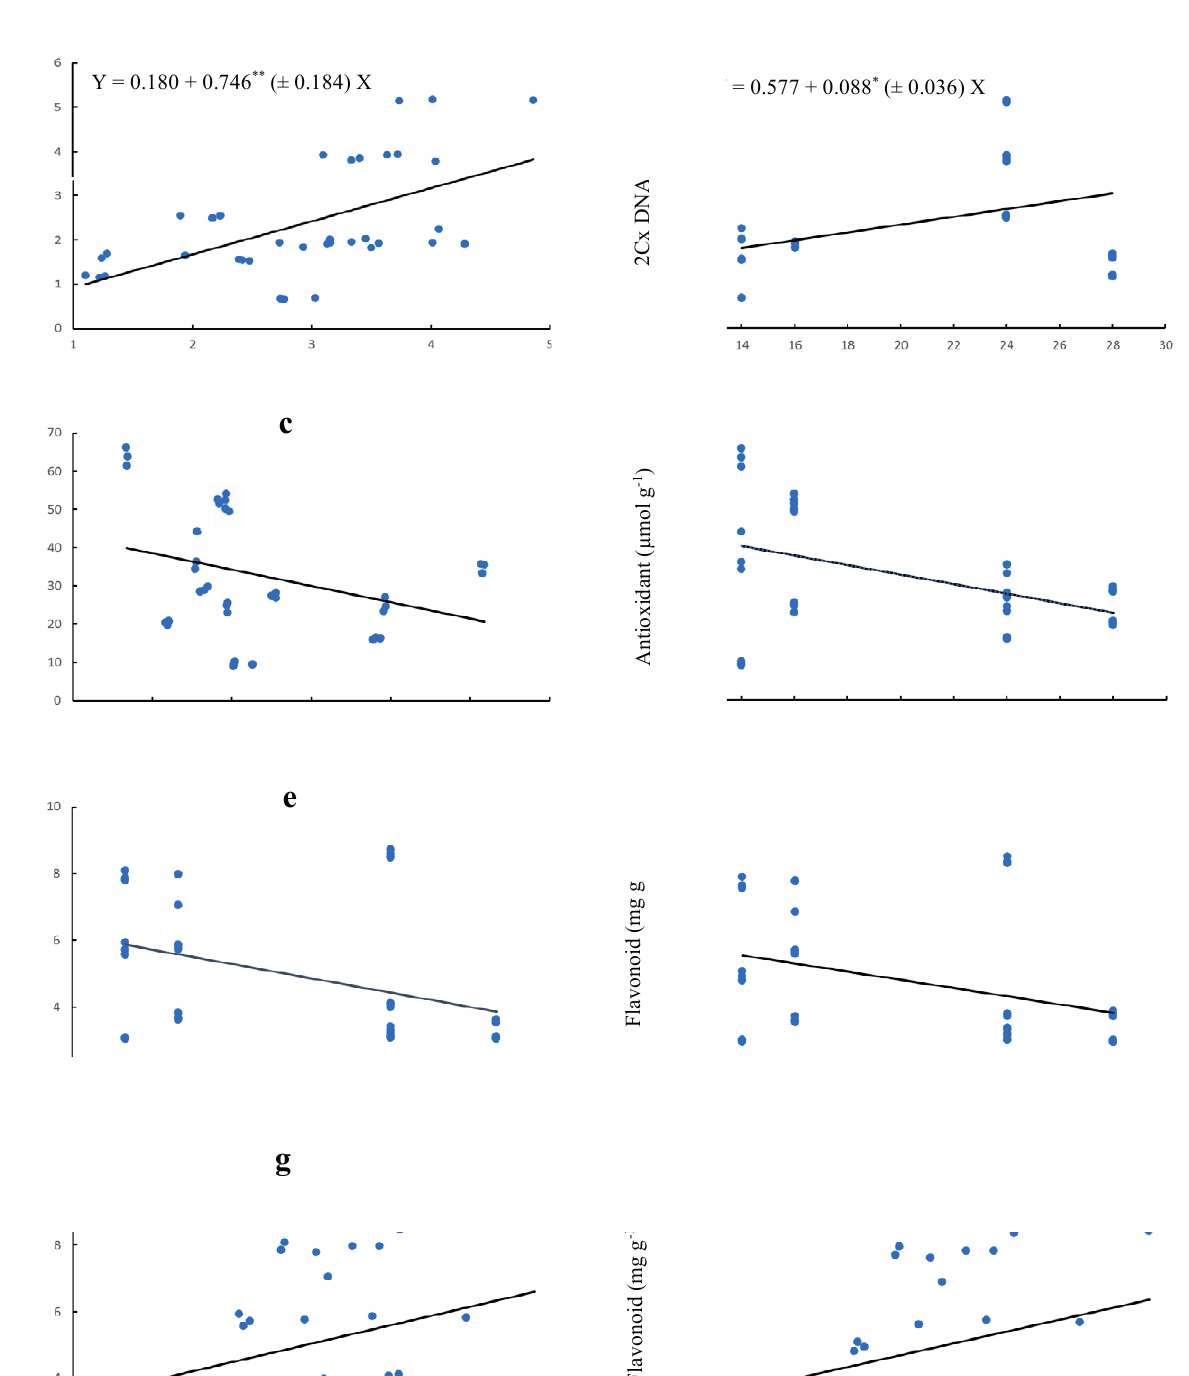
Figure 8. Diagrams of linear regression relationships between diff erent traits of studied berry